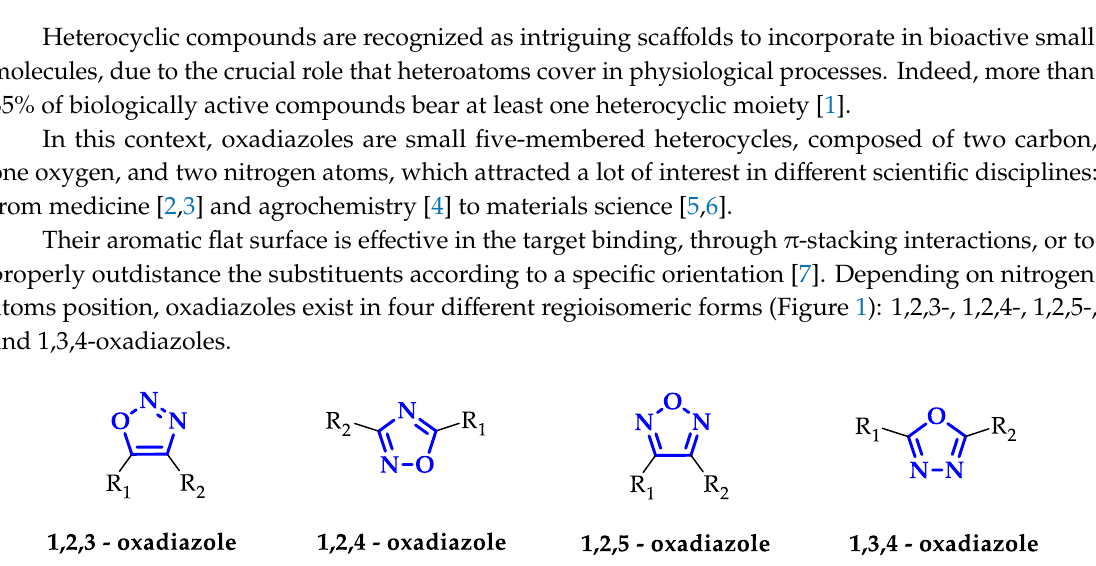
Figure 1. Chemical structures of the four isomers of the oxadiazole.